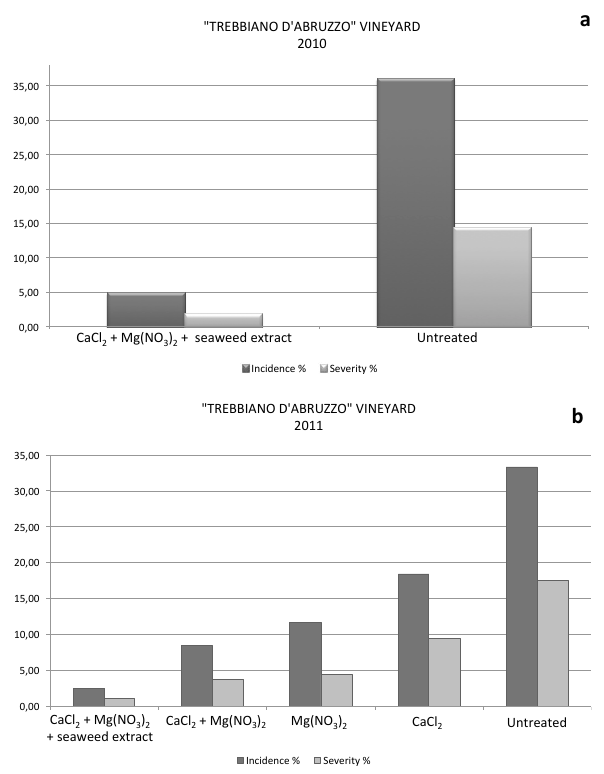
Table 2. Chi-square statistics comparing the full mixture treatment to the untreated control in three trials, showing the highly significant (in bold-italics, P <0.001) differences, and the moderately significant (in italic, P <0.1) differences, both in symptoms incidence and severity. Untreated